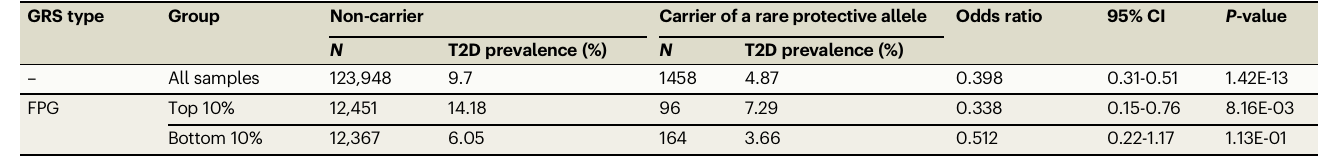
Table 2 | Prevalence of T2D in GRS groups strati fi ed by the presence of a rare protective allele GRS type